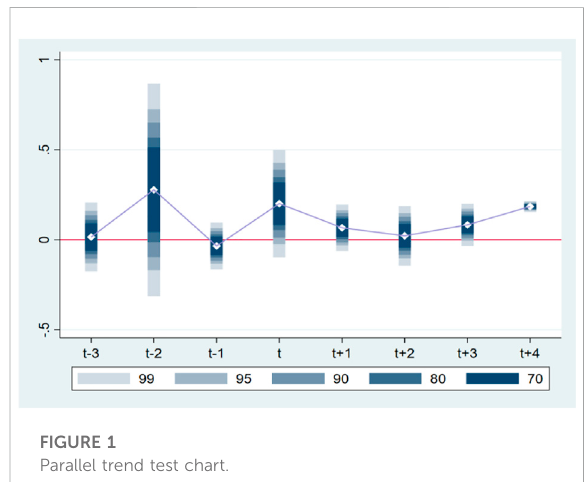
FIGURE 1 Parallel trend test